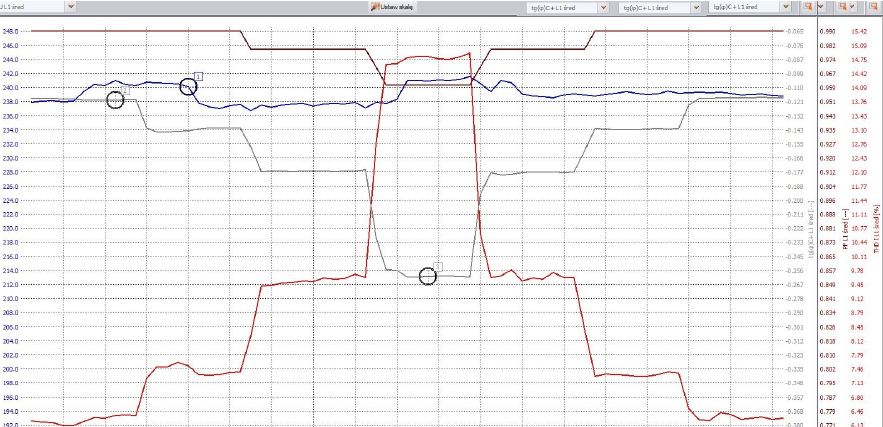
Figure 5. Characteristic changes in voltage, total power factor, THDI, and tg φ in circuit 1 of the tested lighting installation—LED